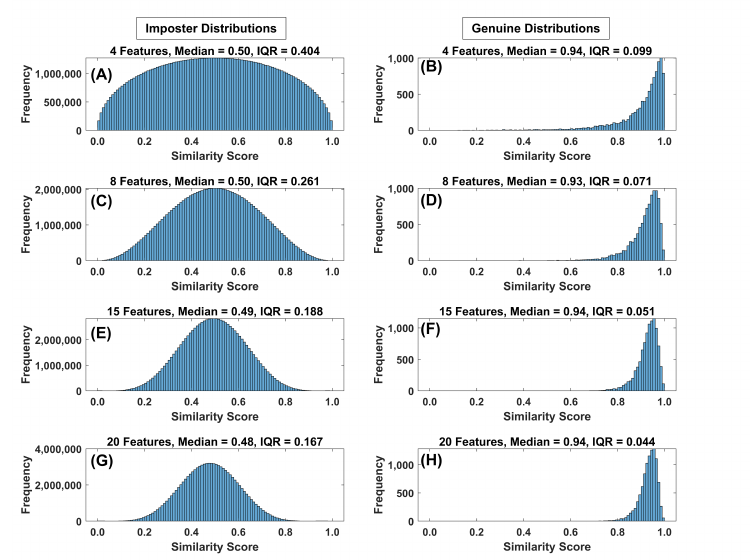
Figure 13. ( A ) Histogram of the impostor similarity score distribution for synthetic data (4 features, Band 8 (all histograms), 10,000 subjects (all histograms)). Note the median and IQR value just above the histogram. ( B ) Histogram of the genuine similarity score distribution for 4 features. ( C ) Histogram of the impostor similarity score distribution for 8 features. ( D ) Histogram of the genuine similarity score distribution for 8 features. ( E ) Histogram of the impostor similarity score distribution for 15 features. ( F ) Histogram of the genuine similarity score distribution for 15 features. ( G ) Histogram of the impostor similarity score distribution for 20 features. ( H ) Histogram of the genuine similarity score distribution for 20 features.